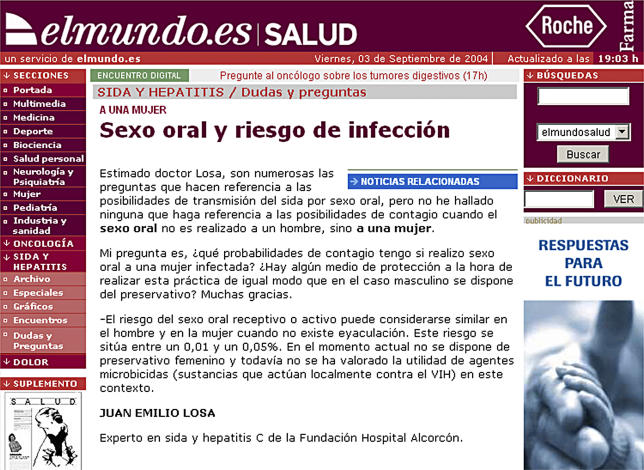
Example of an Answered Question on the Web
Translation of Question and Answer:
Question on oral sex and the risk of infection:Dear Doctor Losa, although there are numerous questions addressing the risk of AIDS transmission through oral sex, I have not been able to find any referring to this risk when oral sex is given by a man to a woman. My question is: what are my chances of contracting AIDS if I give oral sex to an infected woman? Is there a way to perform this practice safely similar to the condom used by men? Thank you.Answer to the female questioner:The risk for either receptive or active oral sex is very similar in men and women. This risk ranges between 0.01% and 0.05%. No feminine condoms are available at the present moment, and the efficacy of microbicide agents (compounds active locally against HIV) has not been evaluated in this setting.JUAN EMILIO LOSA, expert on AIDS and hepatitis, Alcorcón Hospital Foundation